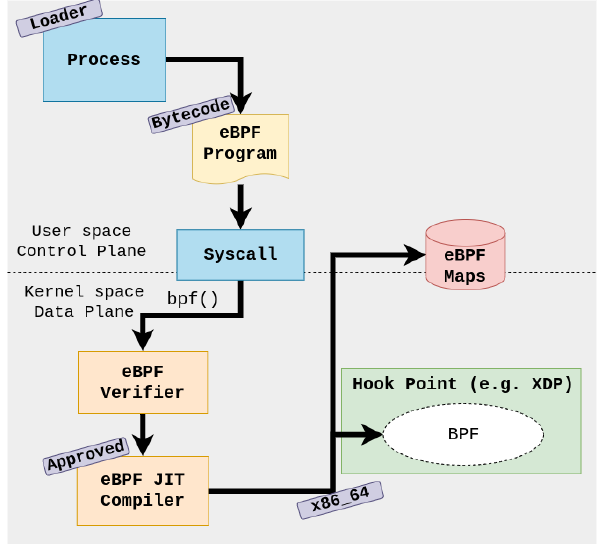
Figure 1. Diagram representing the BPF program load flow in the kernel. Source: adapted from